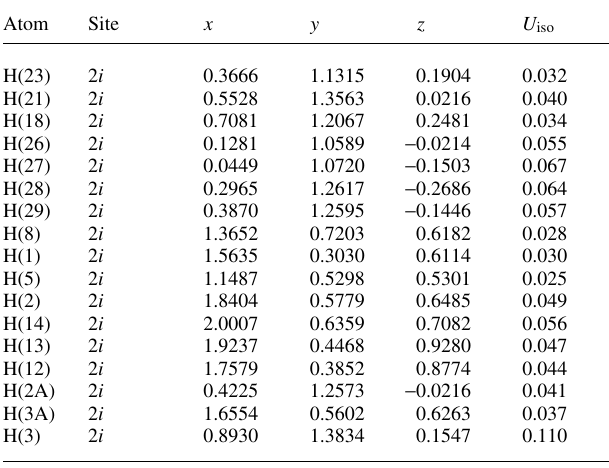
Table 2. Atomic coordinates and displacement parameters (in Å 2 )